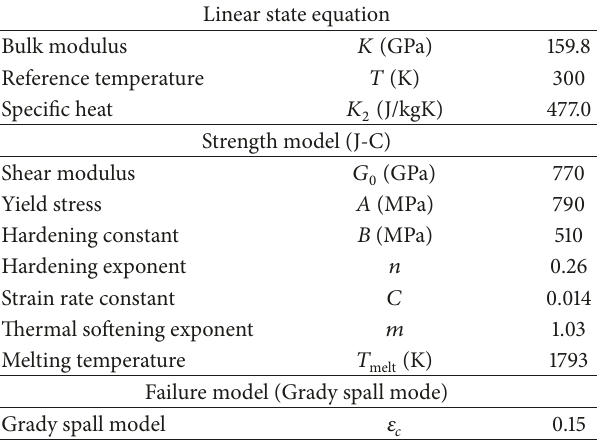
Table 3: Material model of